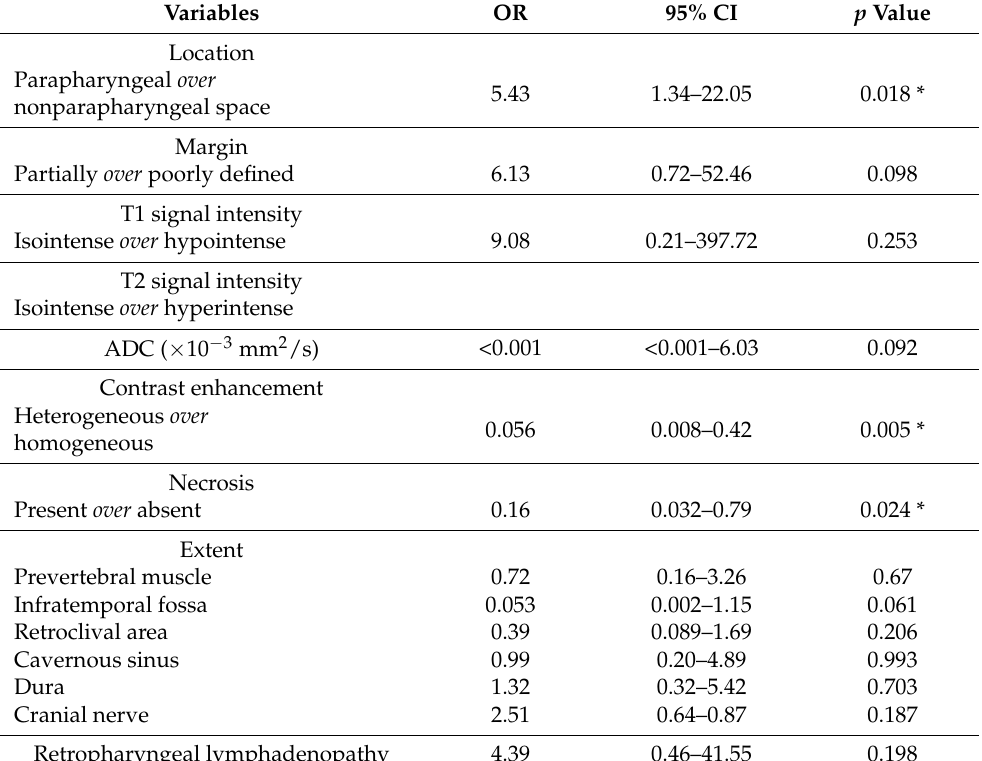
Table 2. Univariable analysis for differentiating GPA from SBO.